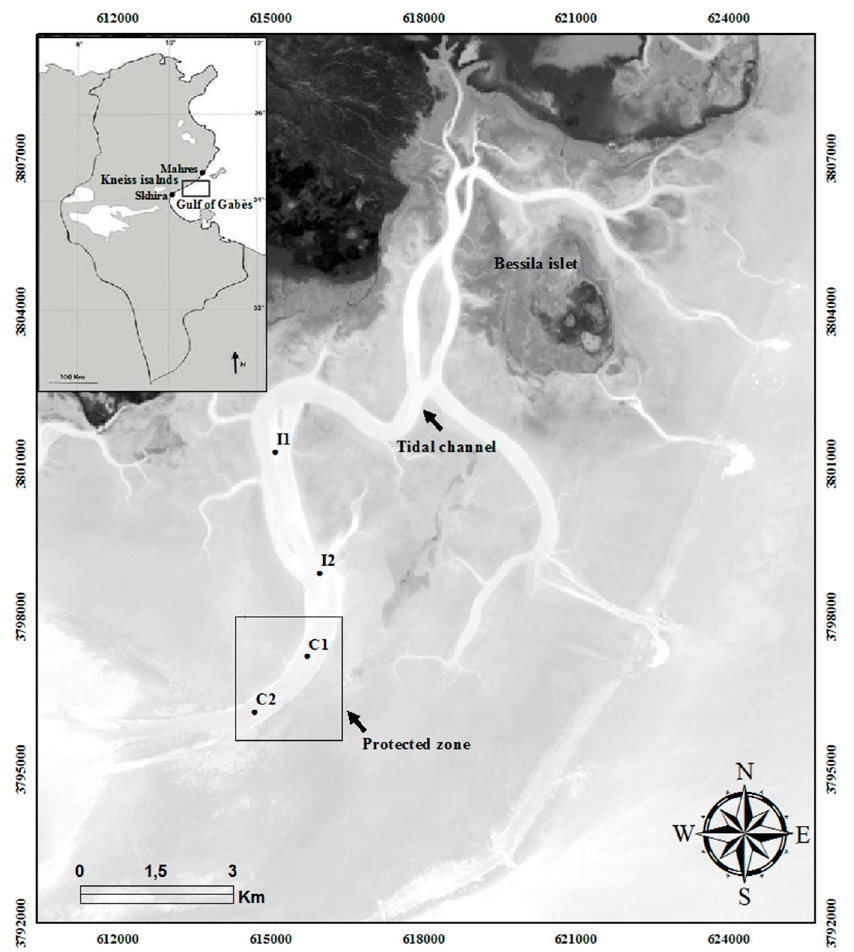
Figure 1. Map of the study area showing the locations of the sampling stations (I1 and I2: trawled zones; C1 and C2: control stations).